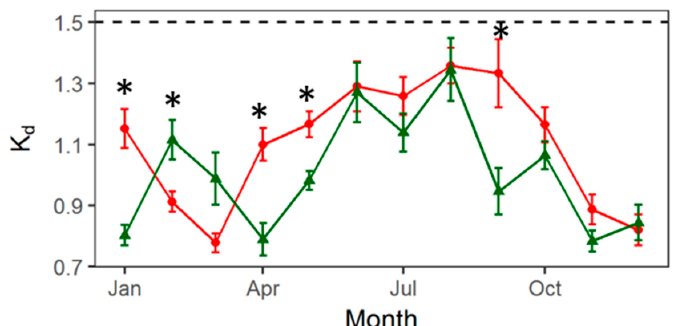
Figure 9. Mean ( ± SE) total suspended solids (TSS mg L − 1 ), chlorophyll ( µ g L − 1 ), and light attenuation (K d m − 1 ) from the Goodwin Island shoal survey station comparing the period of times where seagrass was declining (red; 2001–2005 and 2009–2011), and increasing (green; 2006–2008 and 2012–2014). Stars indicate significant differences ( p < 0.05). Dashed lines indicate the Chesapeake Bay seasonal median habitat requirements for persistent growth to 1m depths.